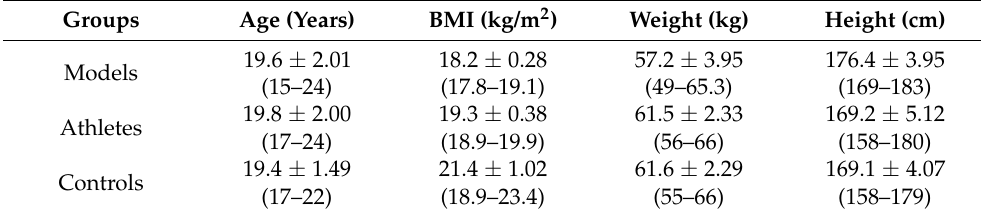
Table 1. Participants’ Anthropometric Characteristics. Mean ± SD (Range).